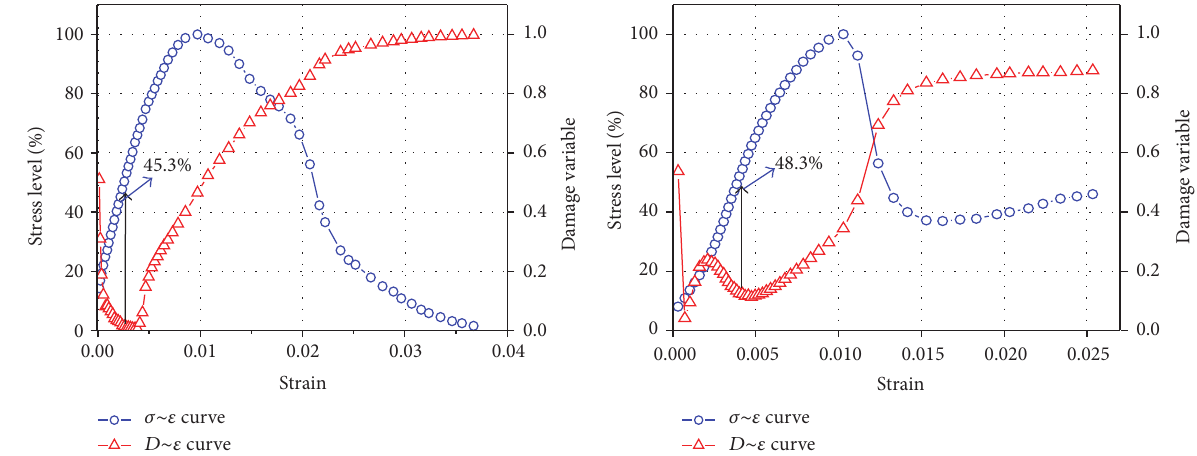
Figure 10: The evolution curves of damage strain stress for coal